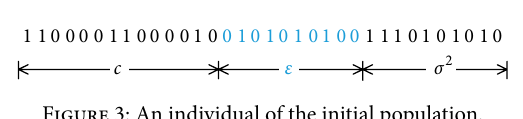
Figure 3: An individual of the initial